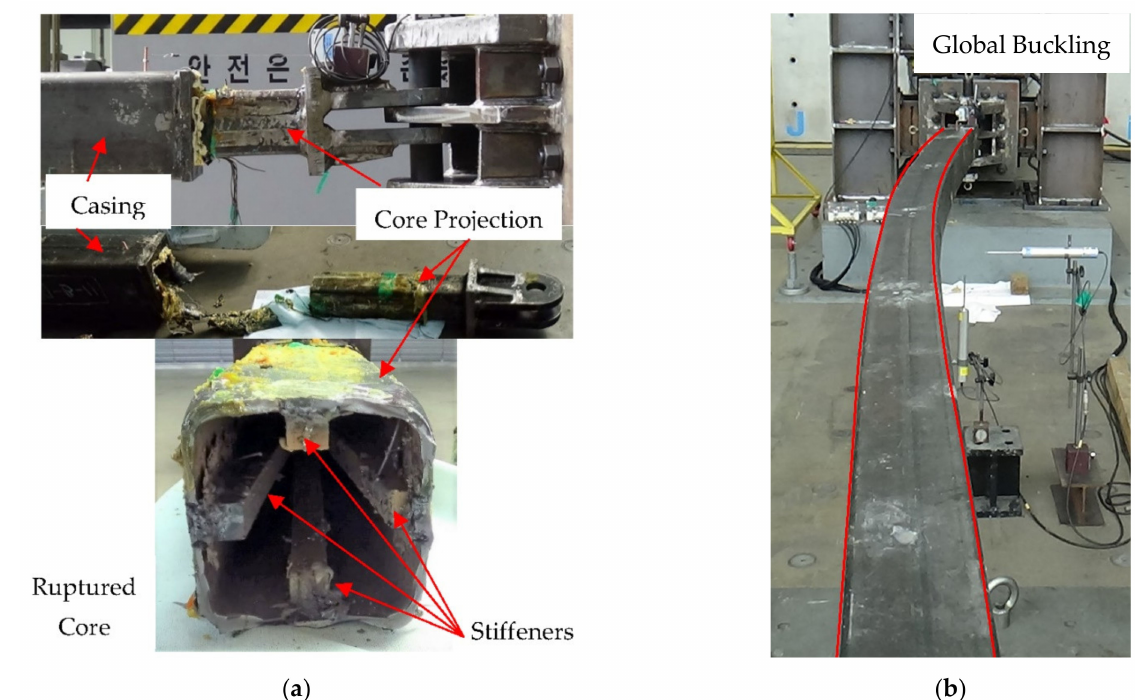
Figure 12. Failure mode of square specimens: ( a ) Core rupture at the end of unconstrained length stiffener in specimens